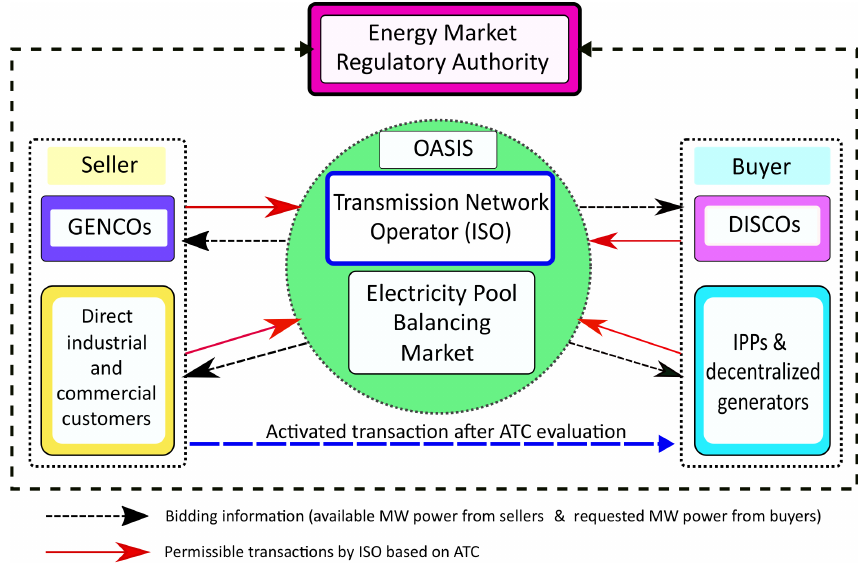
Figure 1. Deregulated electricity market.